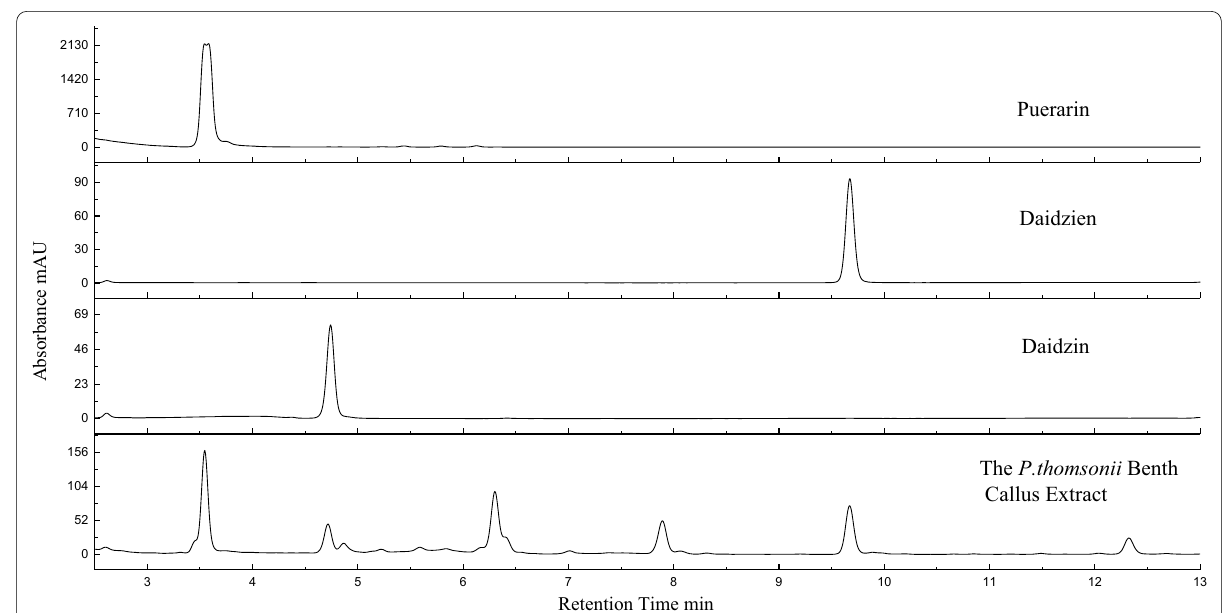
Fig. 2 HPLC chromatograms obtained with UV detection at 270 and 370 nm from the callus extract of P. thomsonii compared with standards puerarin, daidzein and daidzin